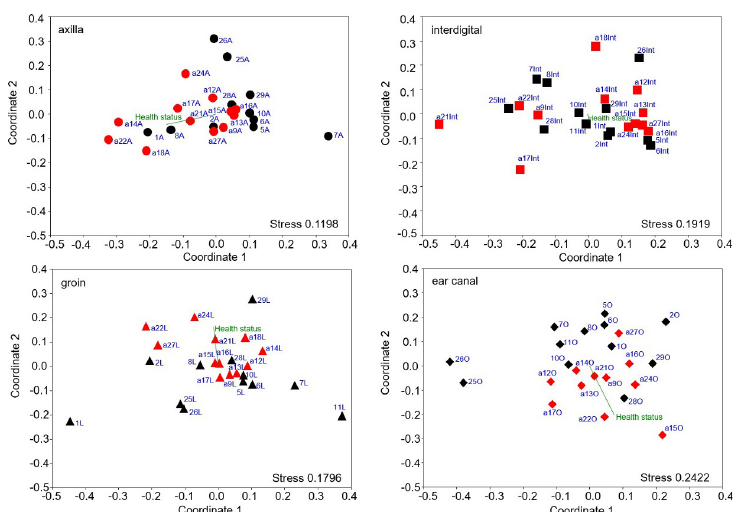
Fig 6. Comparative analysis of the skin microbiota composition of relative abundance patterns at each body site of non-allergic (n = 12; black color) and allergic (N = 12; red color) dogs, performed by NMDS analysis based on a Bray-Curtis similarity matrix. The health status was included as environmental parameter; (A- Axilla, Int- interdigital area, L- groin, O- ear canal).